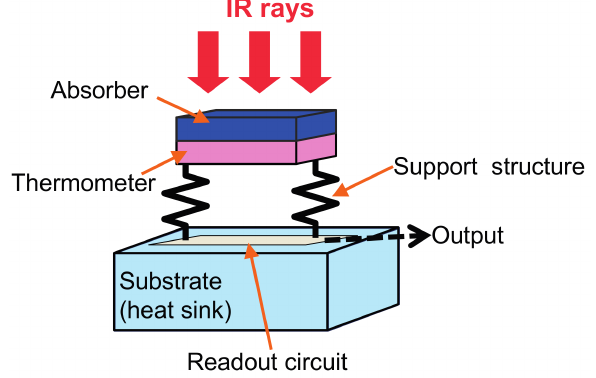
Figure 1. Operation principle of thermal IR